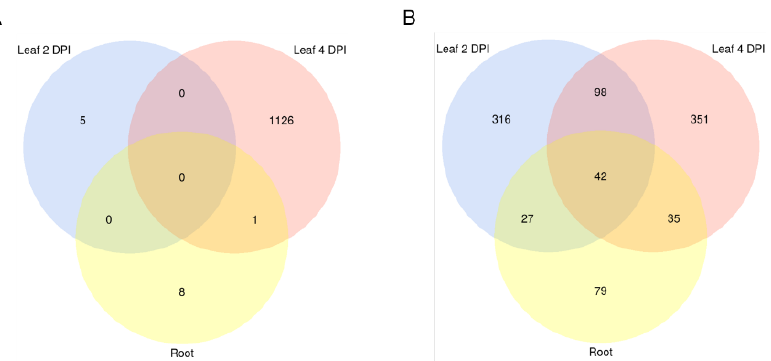
Figure 9. Size composition of unique candidate sRNA effectors from M. oryzae and B. distachyon . The number of unique reads is reported on the y-axis.